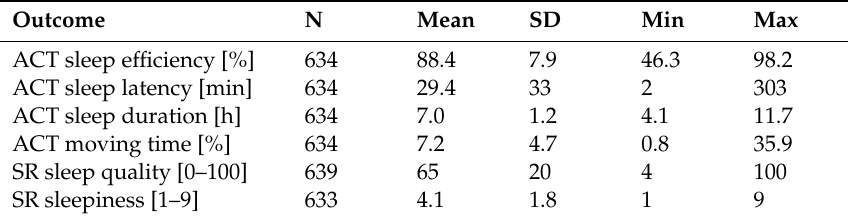
Table 1. Overview of the sleep outcomes (ACT—actimetry; SR—self-reported).